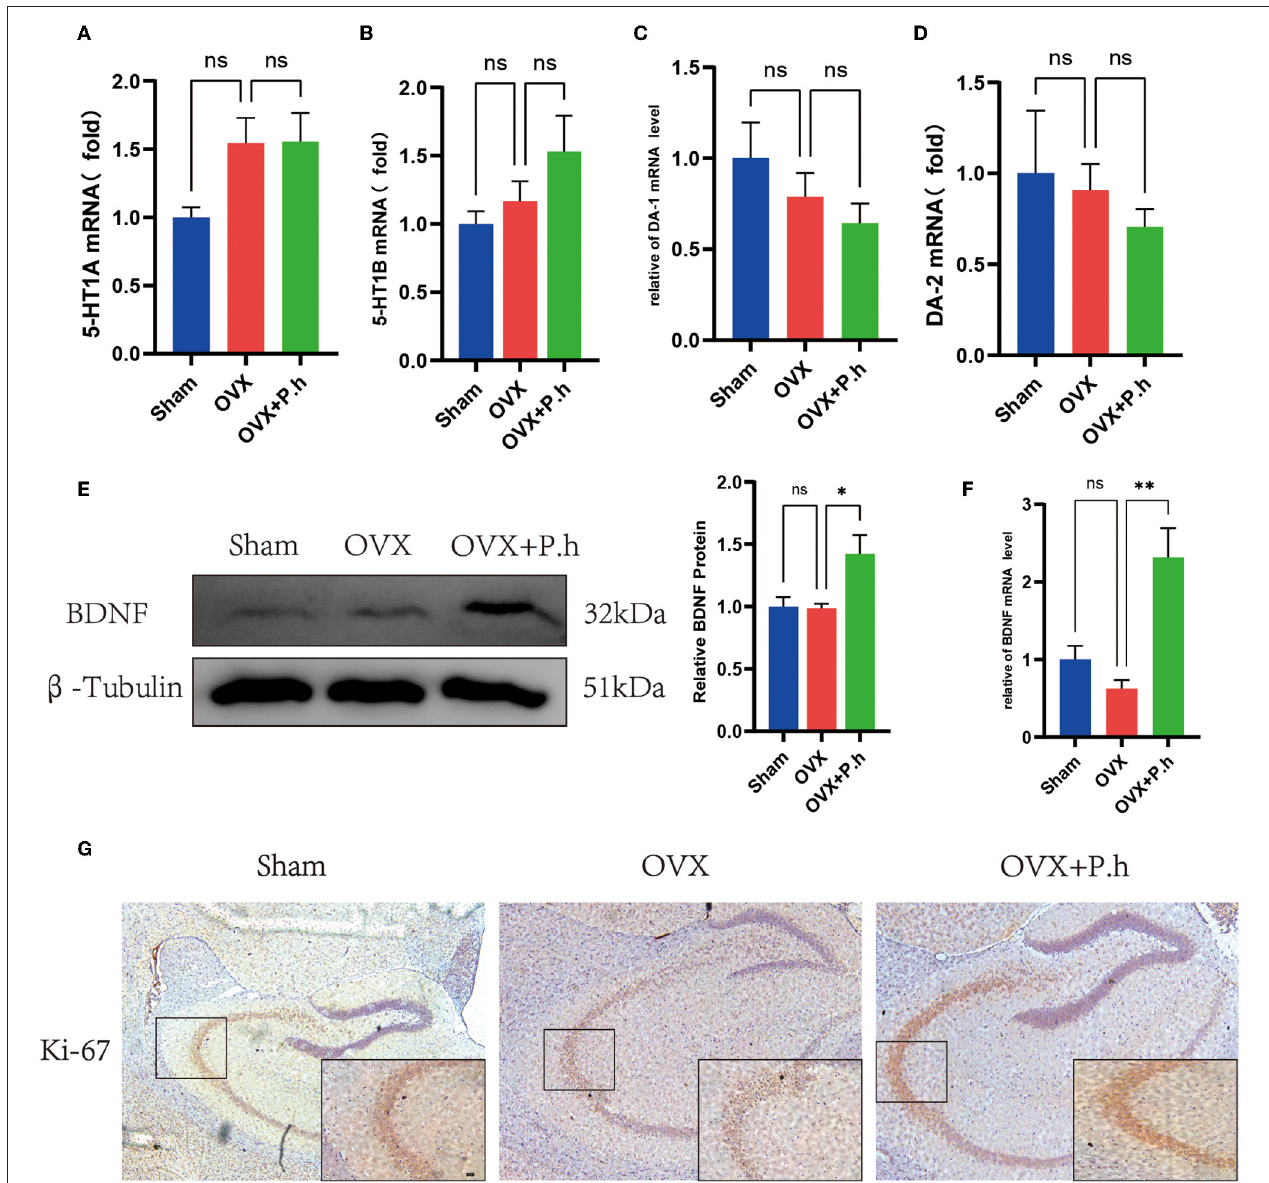
FIGURE 7 | P. histicola increased the level of BDNF for nerve proliferation. (A) 5-HT1A mRNA level in hippocampus. (B) 5-HT1B mRNA level in hippocampus. (C) DA-1 mRNA level in hippocampus. (D) DA-2 mRNA level in hippocampus. (E) BDNF protein level and the ratio of BDNF to β -tubulin in hippocampus. (F) BDNF mRNA level in hippocampus. (G) Immunohistochemistry of hippocampal proliferation marker Ki-67. Magnification 50 × and 400 × . Scale bar = 20 µ m. Data are presented as means ± SEM ( n = 3–4/group). * p < 0.05, ** p < 0.01, ns p >